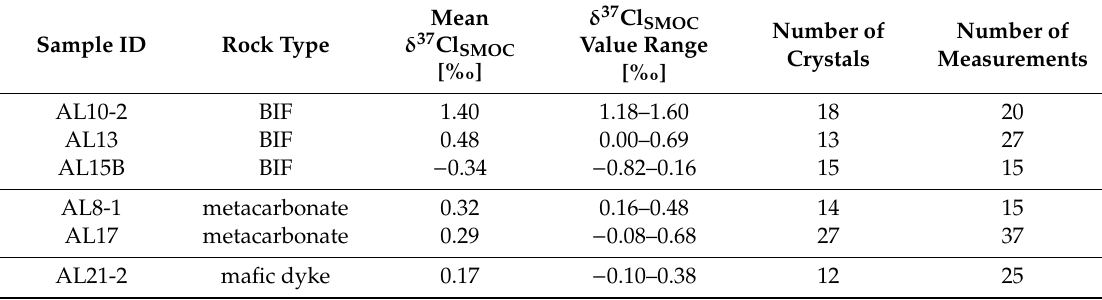
Table 3. δ 37 Cl values of the Isua apatite crystals determined by